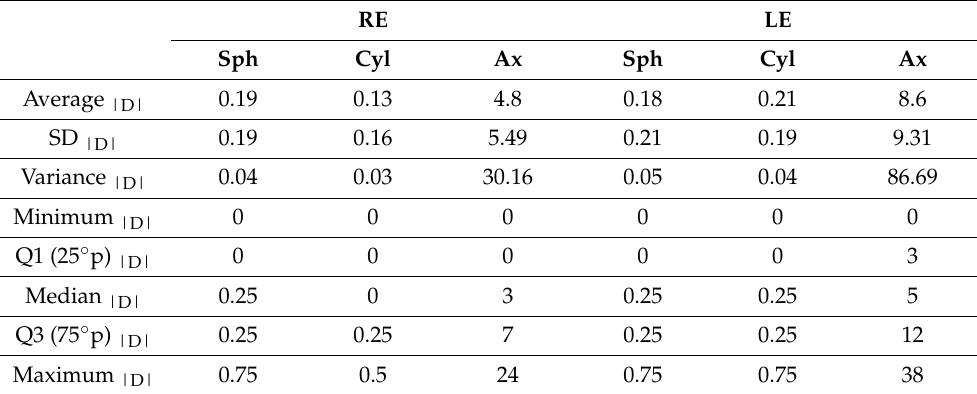
Table 3. Center and dispersion of absolute value between the standing and sitting positions. RE = right eye; LE = left eye; Sph = sphere; Cyl = cylinder; Ax = axis; SD = standard deviation; Q1 = first quartile (25%); Q3 = third quartile.